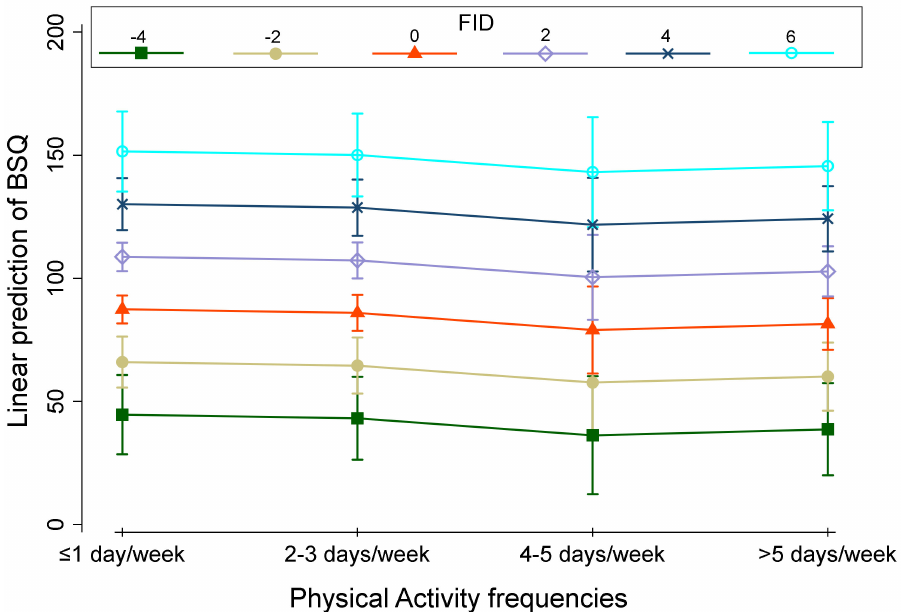
Figure 3. Linear prediction of BSQ by FID for four Physical Activities frequencies.